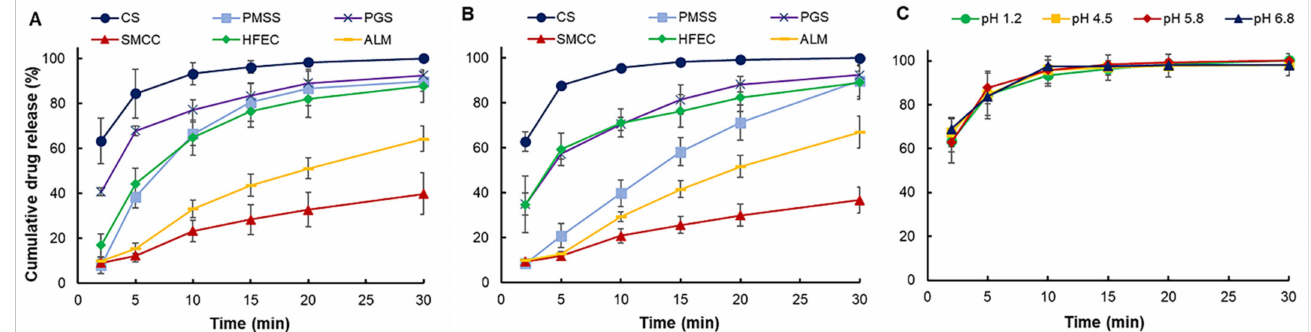
Figure 3. Drug release profiles of paracetamol tablets formulated using various excipients at pH 1.2 ( A ) and 5.8 ( B ), and compiled release profiles of paracetamol-CS formulation at four different pH values along the GI tract ( C